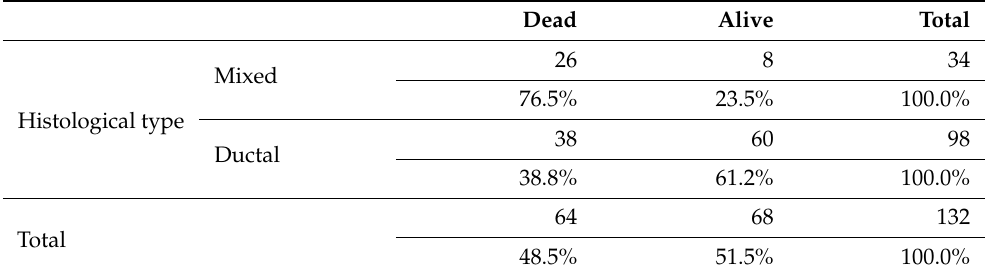
Table 2. Survivorship of 132 women at the end of five-year follow-up period. Dead Alive Total Mixed Histological type